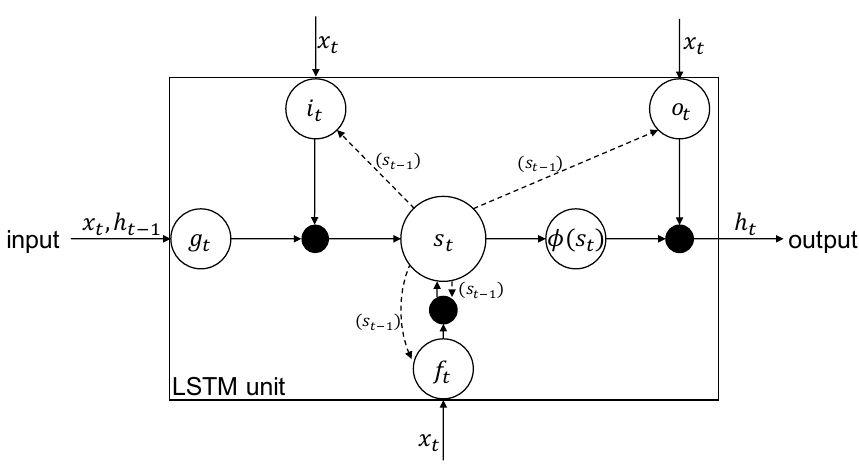
Figure 2. Schematic representation of an LSTM unit. Adapted from [36]. The filled in circles represent the pointwise multiplication operation denoted by (cid:12) in Equations (6) and